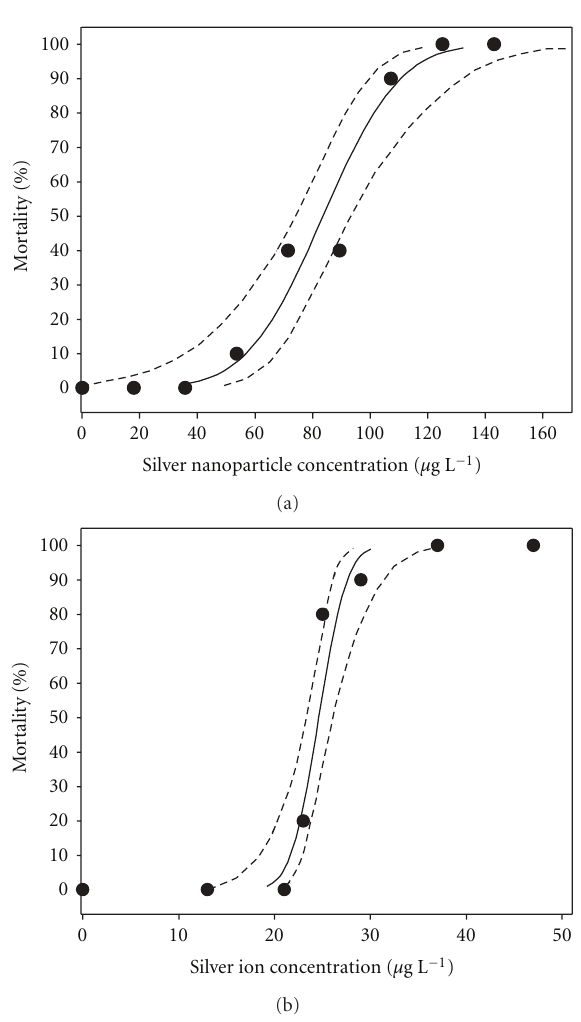
Figure 3: Toxicity of 81nm silver nanoparticles (a) and silver ions (b) after 48 hours exposure to adult male zebrafish ( Danio rerio) in a static renewal experiment. Black circles ( • ) represent the mean survival in percent after exposure to a given concentration ( n = 10). Solid lines indicate the calculated lethality using probit analysis after exposure to silver nanoparticles and silver ions, respectively. Dashed lines indicate the 95% confidence